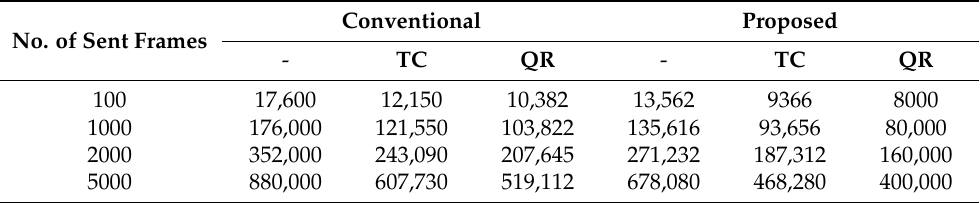
Table 3. Traffic-reduction performance against numbers of sent frames for the conventional and proposed architecture, where “-” denotes no reduction technique being used.